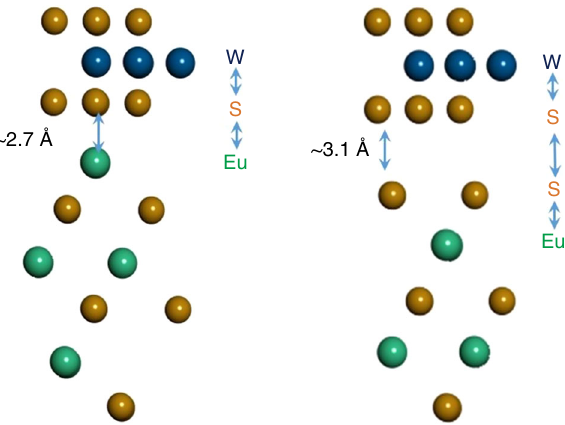
Fig. 4 Structural model. Schematic diagram of the structural model of WS 2 / EuS for Eu-terminated (left) and S-terminated (right) surfaces of EuS